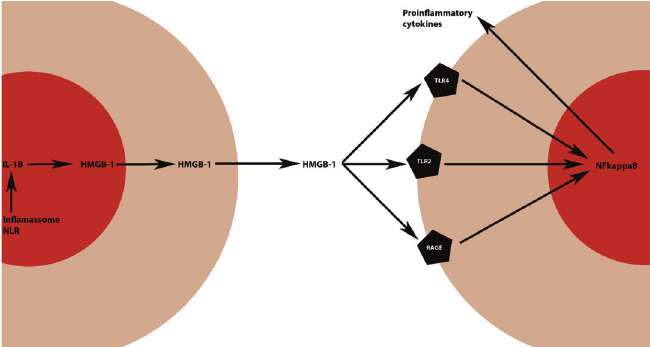
Figure 1. Functional association between HMGB-1 and inflammasome. NLR (nucleotide-binding oligomerization domain-like receptor) is a complex of proteins that release IL-1B. IL-1B induces the HMGB-1 nuclear translocation to cytoplasmic. Exogenous HMGB-1 can act via receptors (RAGE, TLR2 and TLR4) to stimulate NF-kappa B, release pro-inflammatory cytokines, and elicit injurious inflammatory